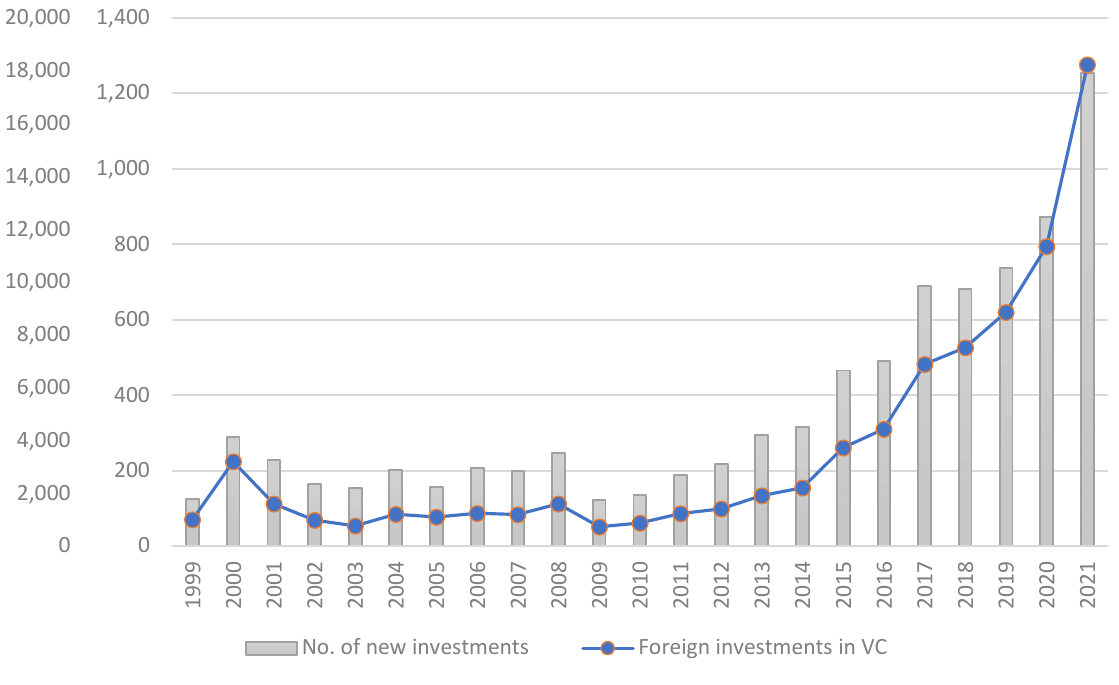
Figure 2. VC investment in M$ and new VC-backed investment rounds: 1999–2021. Source: authors’ analysis of the IVC and MoneyTree reports 2000–2022.